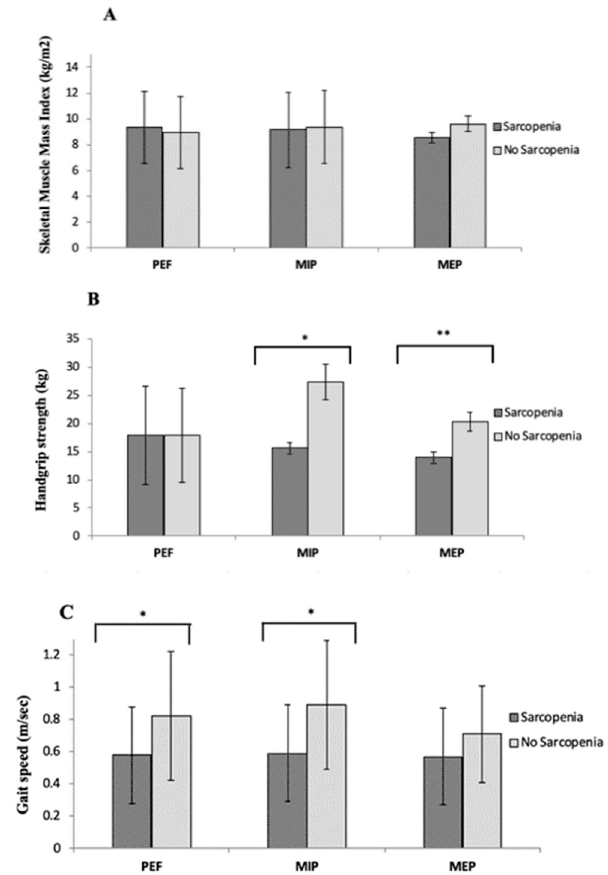
Figure 3. Mean difference of muscle mass ( A ), Handgrip strength ( B ) and gait speed ( C ) according to the presence of each respiratory muscle sarcopenia criteria. * p < 0.05; ** p < 0.001.